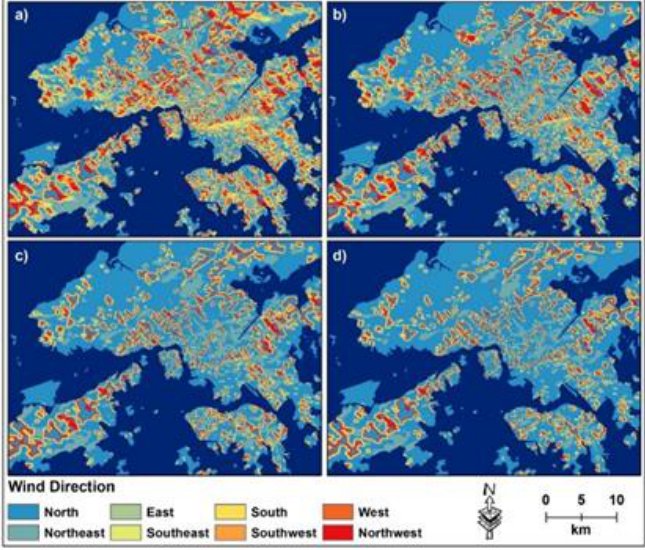
Figure 6. Wind direction measured in Hong Kong (18 September 2018) using the Airflow Analyst at different ground heights: ( a ) 1 m, ( b ) 9 m, ( c ) 22 m and ( d ) 30 m.